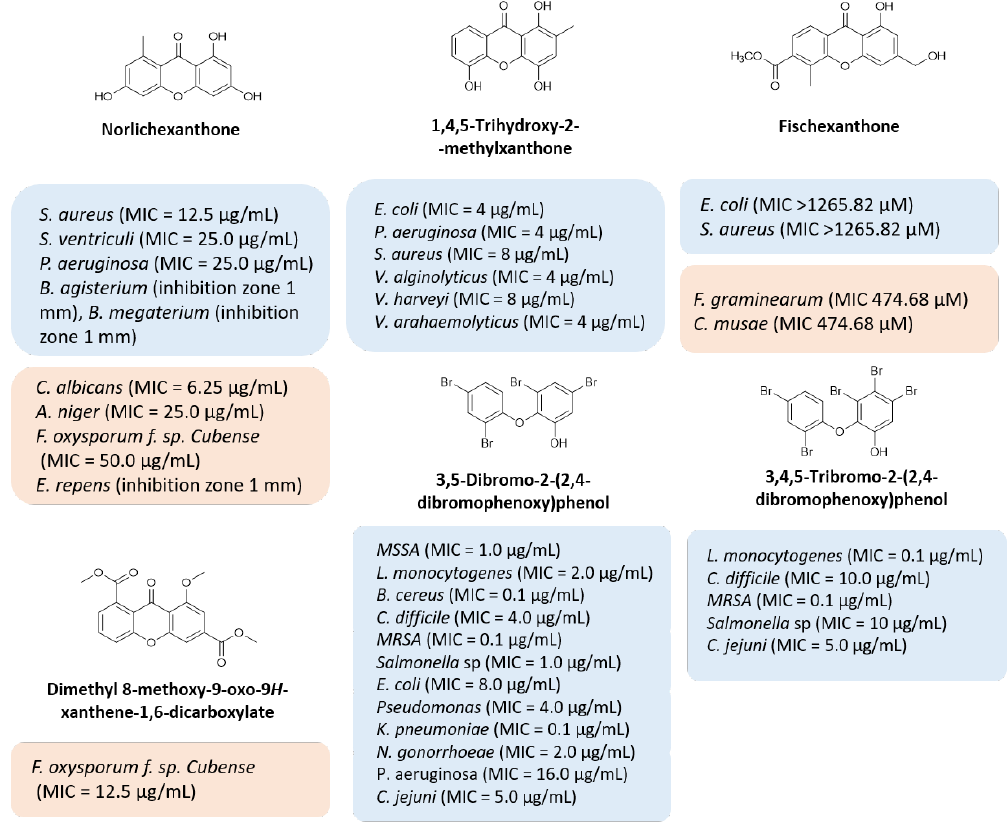
Figure 1. Representative natural compounds with antimicrobial activity. Adapted from [1] .